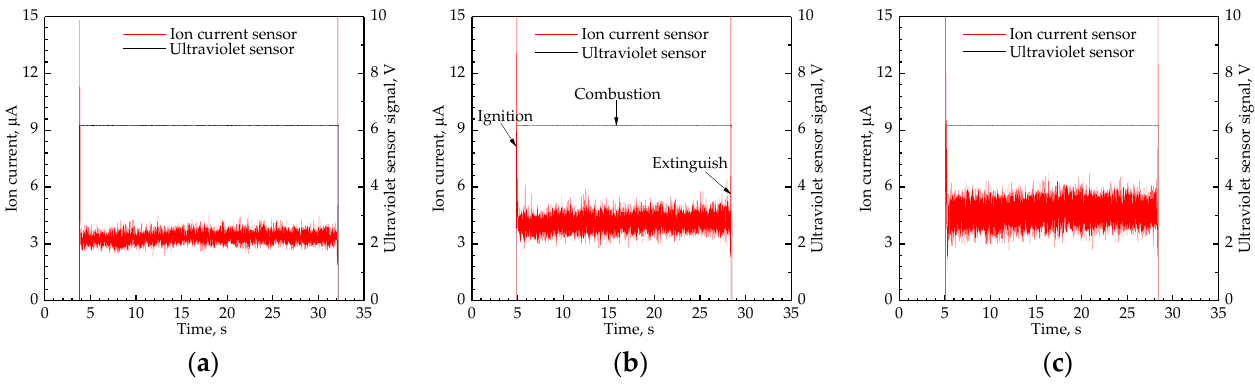
. . . Q f = 50 L/h; ( b ) Q f = 100 L/h; ( c ) Q f = 150 L/h. . Q = 50–230 L/h f